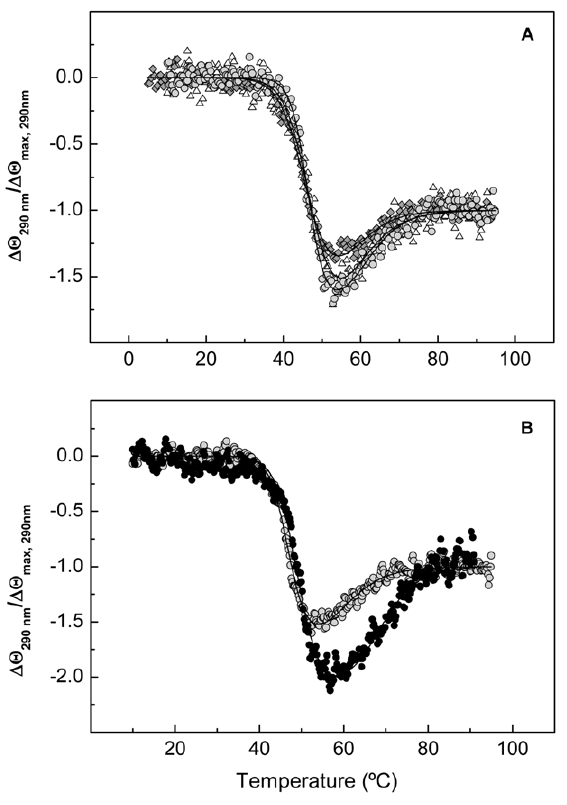
Figure 7. Influence of Cpl-7 potential ligands in the CM and CWBM structural stabilities. ( A ) shows the CD denaturation profiles of Cpl-7 at 290 nm in the absence (grey circles) and in the presence of 10 mM (GlcNAc) 6 or 10 mM MurNAc- L -Ala- D -isoGln (white triangles and grey diamonds, respectively). ( B ) depicts the denaturation profiles in the absence and in the presence of 17.3 mM GlcNAc-MurNAc- L -Ala- D - isoGln (grey and black circles, respectively) at the same wavelength and